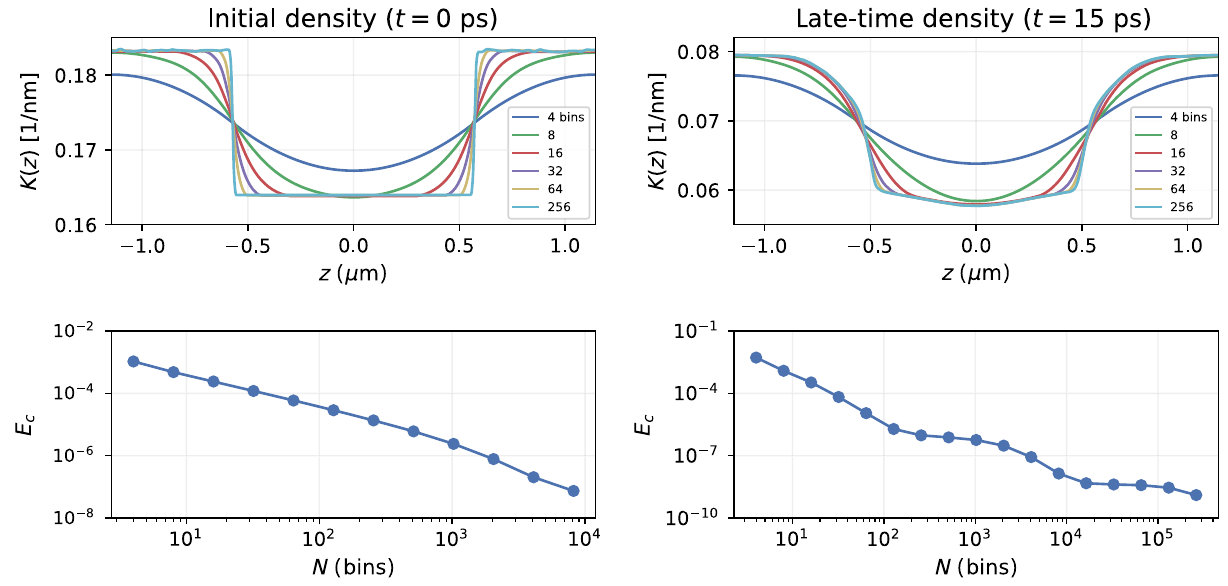
K − K = k K , where c ¼ k c k c k